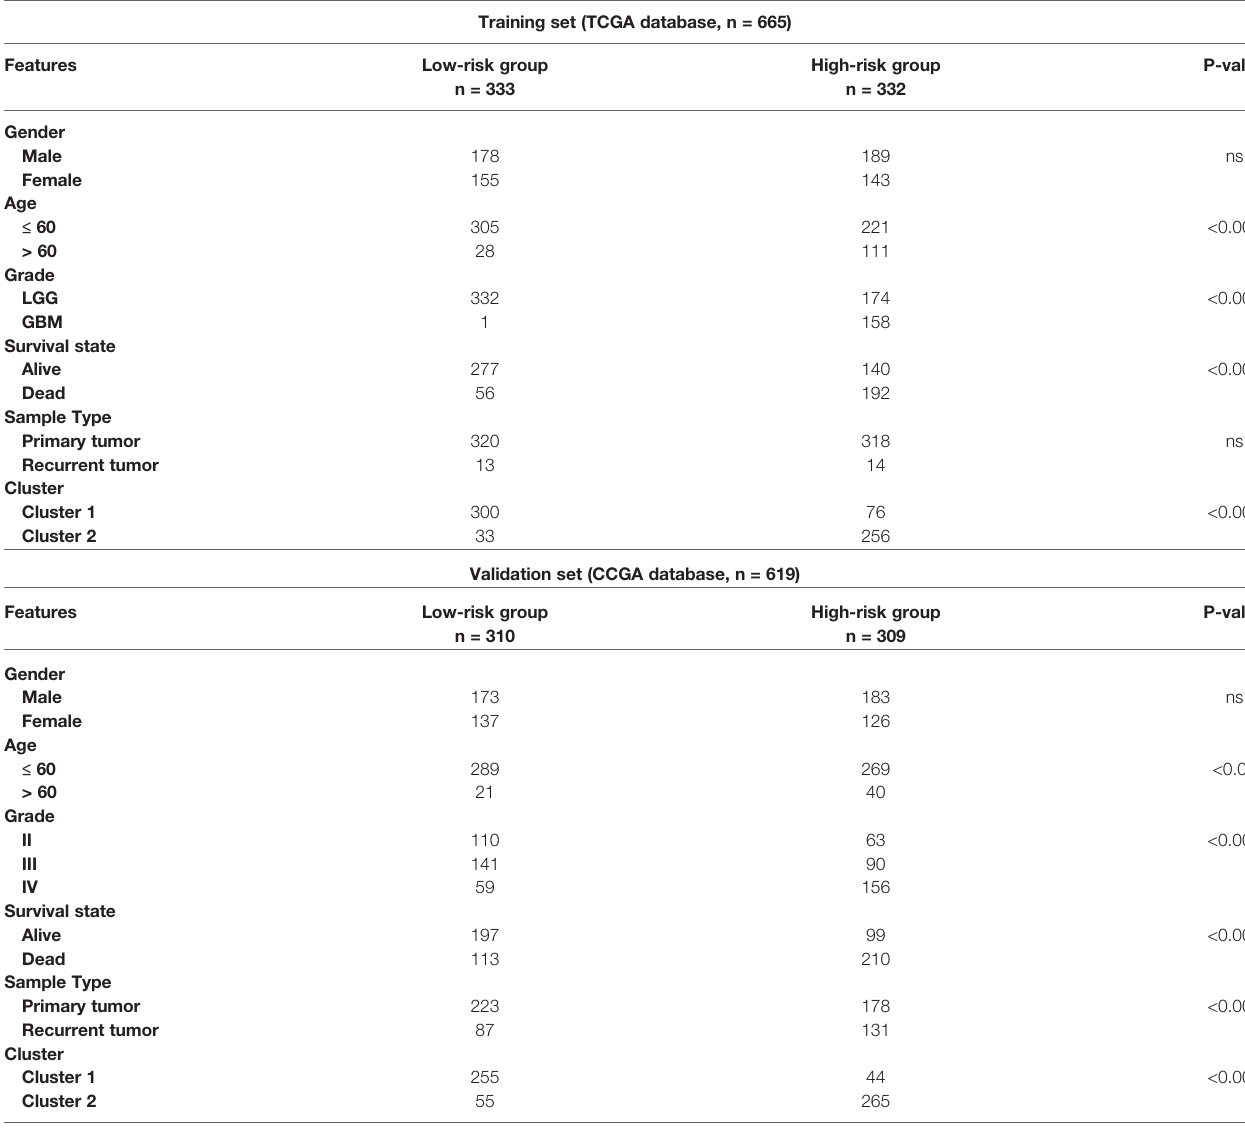
TABLE 2 | Correlation between risk scores and clinicopathological factors of glioma patients in the two cohorts. Training set (TCGA database, n =